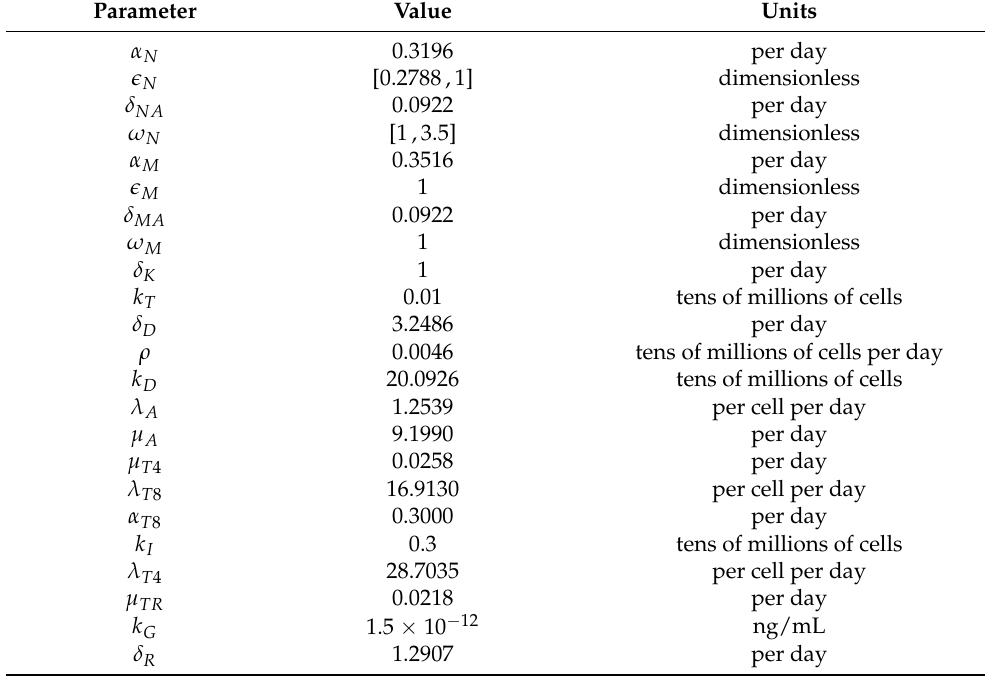
Table 3. Parameter values estimated by data